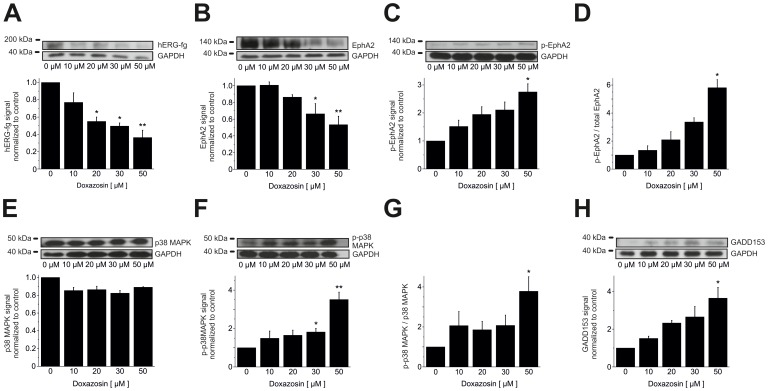
Apoptotic signaling in LNT-229 cells.(A) Human ether-a-go-go-related gene (hERG) K+ channels exhibited reduced expression in the presence of doxazosin. (B) Doxazosin-induced apoptosis was further associated with lower erythropoietin-producing human hepatocellular carcinoma receptor tyrosine kinase A2 (EphA2) protein levels. Enhanced phosphorylation (i.e. activation) of EphA2 (C, normalized p-EphA2 levels; D, p-EphA2 relative to total EphA2) and of p38 mitogen-activated protein kinase (MAPK; F, normalized p-p38 MAPK levels; G, p-p38 MAPK relative to total p38 MAPK) was observed, while total p38 MAPK levels were not significantly affected by doxazosin (E). Finally, growth arrest and DNA damage inducible gene 153 (GADD153) protein levels were elevated upon doxazosin treatment (H). Original Western Blots and mean data normalized to control conditions obtained from n = 3 independent assays (± SEM) are provided (*p<0.05; **p<0.01). GAPDH, glyceraldehyde-3-phosphate dehydrogenase.